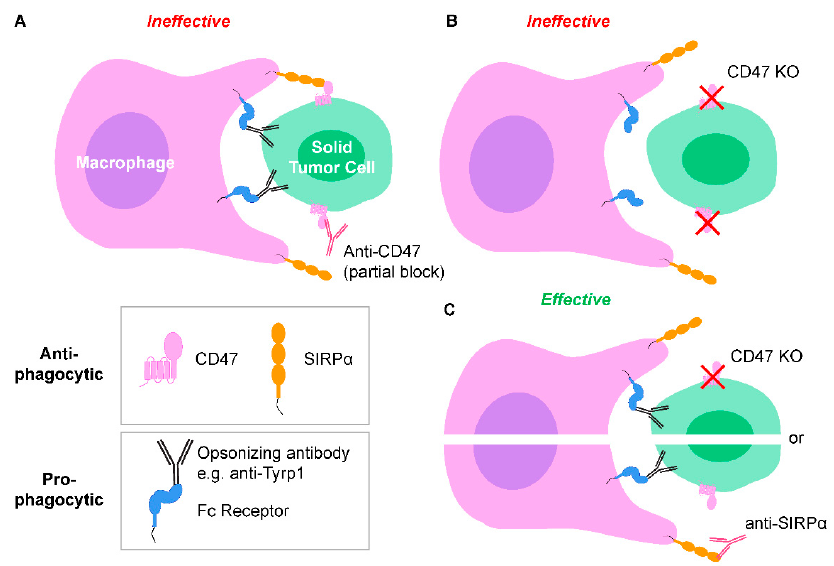
Figure 1. CD47-SIRP α signaling and pro-phagocytic cues between macrophages and solid tumor cells. ( A ) Fc regions of tumor-opsonizing antibodies bind to Fc receptors on macrophages, and Fab regions bind to tumor cell antigens. These signals act as a pro-phagocytic cues, but phagocytosis is ineffective when CD47 is only partially blocked by anti-CD47. ( B ) Complete knockout (KO) of tumor cell CD47 to ablate CD47-SIRP α signaling without a pro-phagocytic signal results in ineffective phagocytosis. ( C ) Both tumor cell CD47 KO (or anti-SIRP α block on macrophages) and tumor-opsonizing antibodies results in effective phagocytosis.